Question: According to the figure, is the described quantity increasing or decreasing?
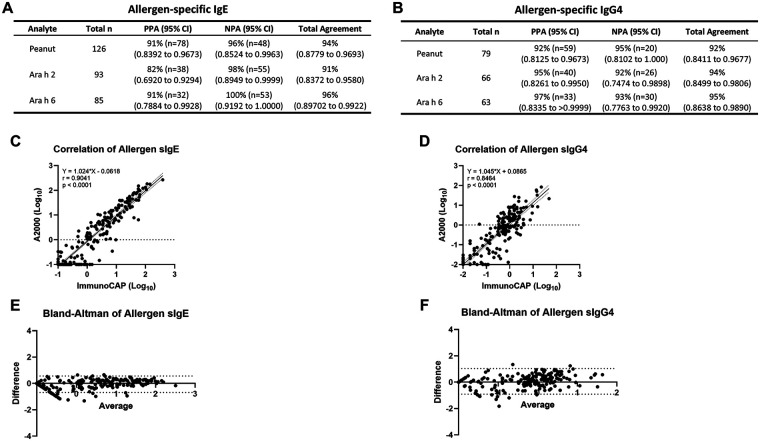
Answer: increasing